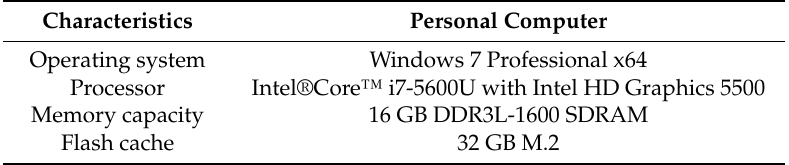
Table 1. Characteristics of the personal computer employed for data processing.